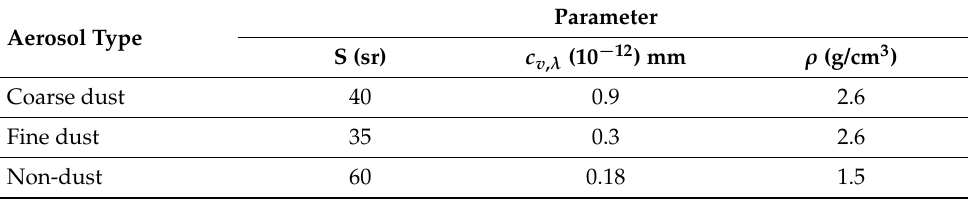
Table 2. Parameters applied to convert particle backscatter coefficient to mass concentration. Aerosol